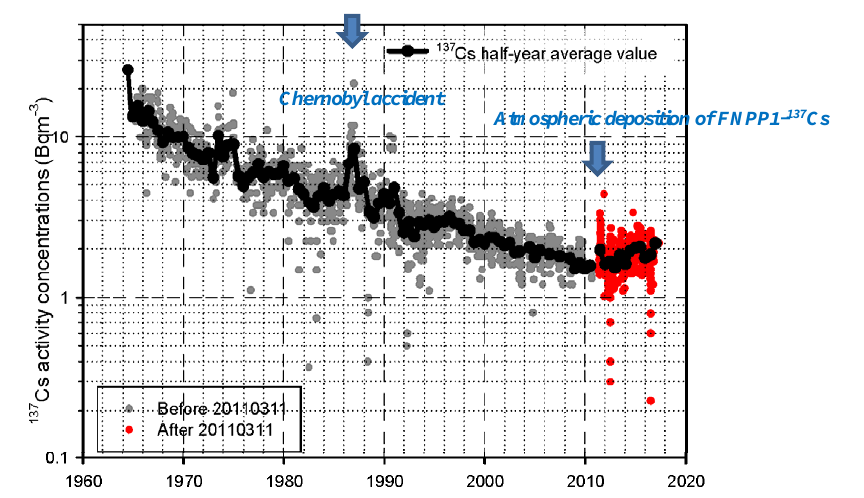
Figure 2. Temporal variations in the 137 Cs activity concentrations in surface seawater in the Sea of Japan during the period from 1960 to 2016. Circles indicate measured values, and red circles indicate data measured after the accident (11 March 2011). Black circles indicate the 0.5-year average value. Standard deviations of data were removed to clearly show the temporal